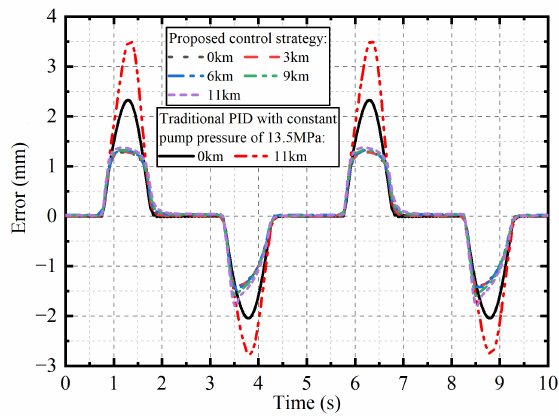
Figure 9. Tracking error of multi-step movement.